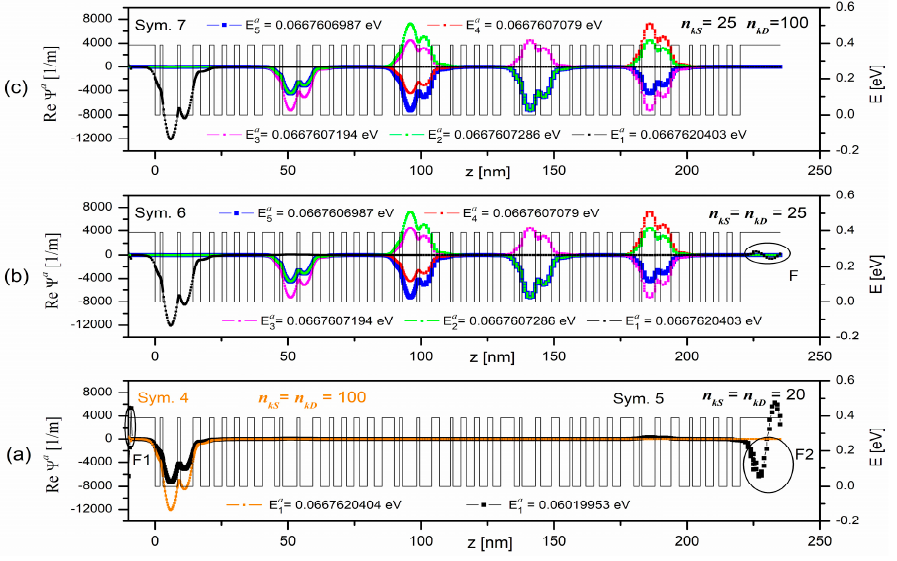
Figure 8. Illustration of the series (9) convergence with the solutions of the Schrödinger equation (Re Ψ b ) depending on the degree of the approximating polynomial represented by the parameters n kS and n kD . The calculations were performed for the first minibandof the structure consisting of 5 QCL periods reported in [28]. Basic simulation parameters are included in Table 5. Graph ( a ) shows the wave functions (Re Ψ b ) calculated for the parameters n kS = n kD = 20, graph ( b ) is the same wave functions calculated for the parameters n kS = n kD = 25, and graph ( c ) illustrates the above wave functions calculated for the parameters n kS = 25 and n kD = 100.